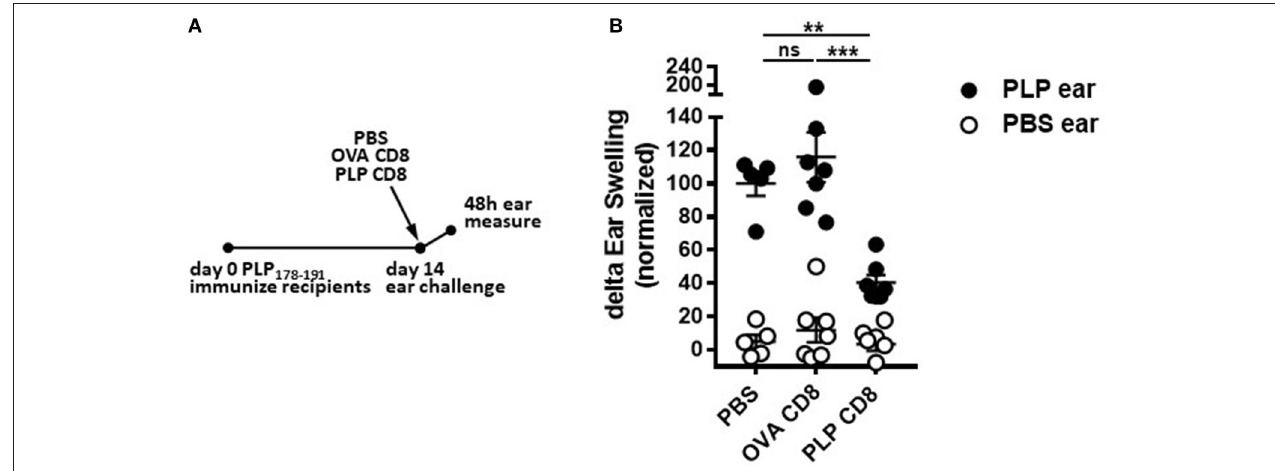
FIGURE 3 | PLP-specific CD8T cells rapidly suppress PLP-specific CD4T cell responses in vivo . Mice were immunized with PLP178-191/CFA on day 0. At day 14, these mice were injected i.v. with either PBS or adoptively transferred OVA-CD8 or PLP-CD8. On the same day, the ear pinnae were challenged with either PLP178-191 peptide or PBS as a control. Ear swelling was measured at 48h and normalized to control (untransferred) group swelling mean. n = 6–7 per group. Data are representative of two replicates. ** p < 0.01; *** p <